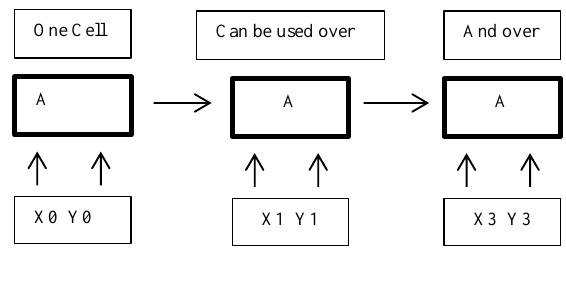
Figure 2. Basic RNN